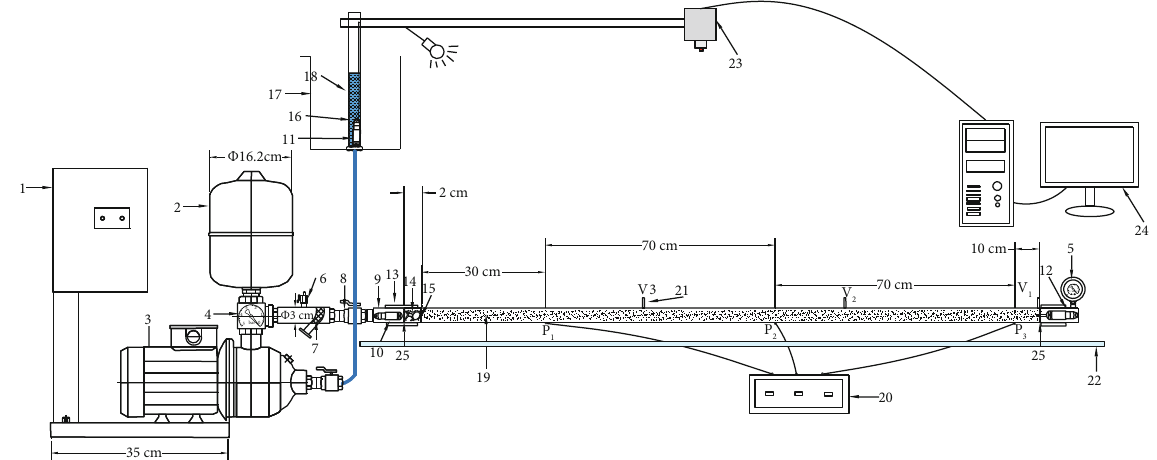
Figure 1: Schematic diagram of the fl uid- fl uid fl ow (Figure 1). The system consisted of a transparent Perspex pipe of 182 cm length, 3.01 cm inside diameter, and 4.62 cm